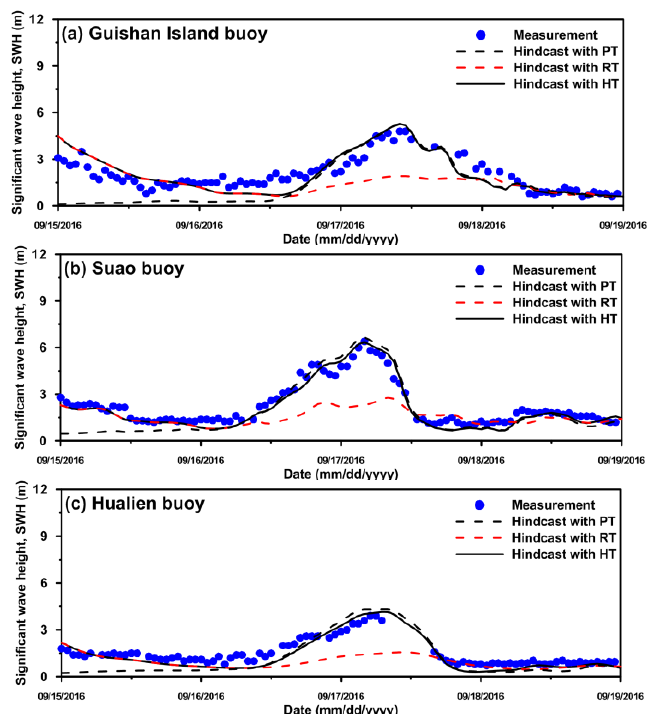
Figure 9. Comparison of the significant wave height (SWH) between model predictions and measurements at the ( a ) Guishan Island, ( b ) Suao, and ( c ) Hualien buoys for Typhoon Malakas (2016). PT: Parametric typhoon model; T: Reanalysis typhoon wind data; HT: Hybrid typhoon model.